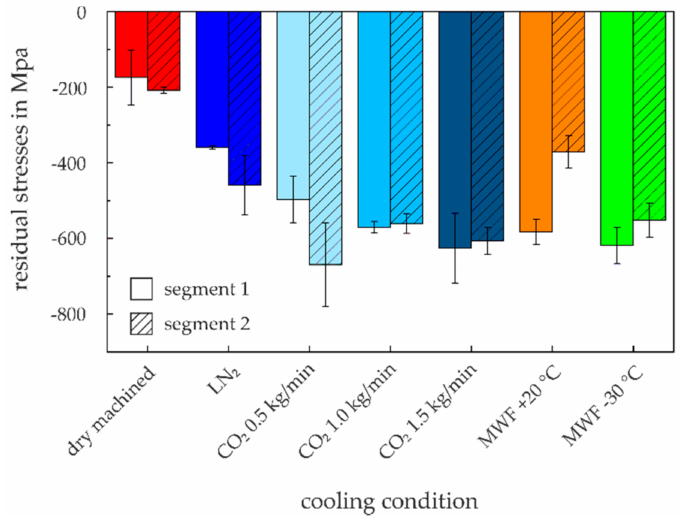
Figure 5. Axial residual surface stresses measured at the beginning (segment 1) and the end (segment 2) of the turned specimen